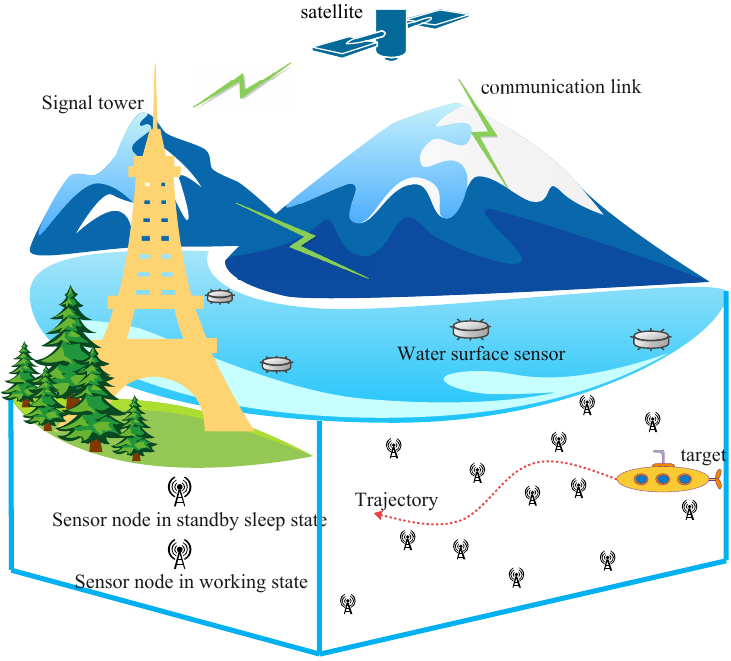
Figure 1. Network structure Figure 2. 2D detection